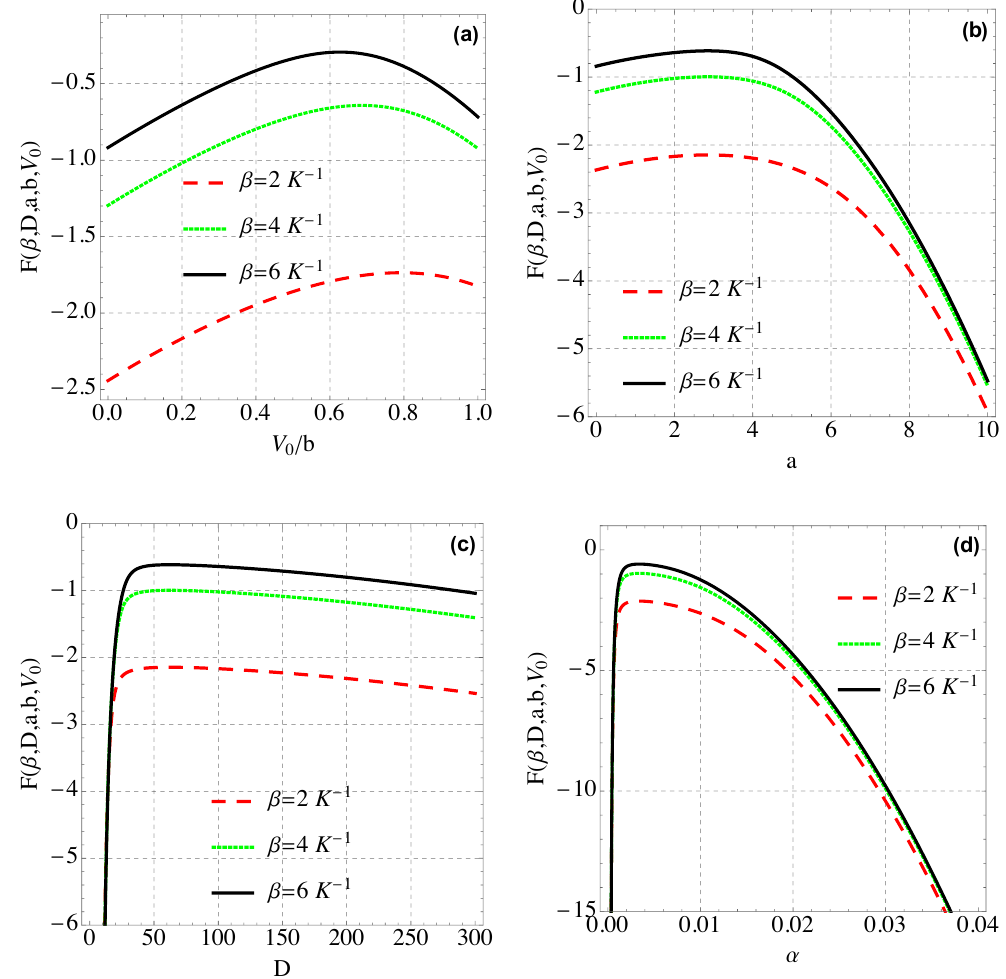
Figure 3. ( a ) Plots of free energy F ( β , D , a , b , V 0 ) versus V 0 / b , ( b ) parameter a , ( c ) D and ( d ) screen- ing parameter α for different values of β = 2.0K − 1 (red curve), 4.0K − 1 (green curve), 6.0K − 1 (black